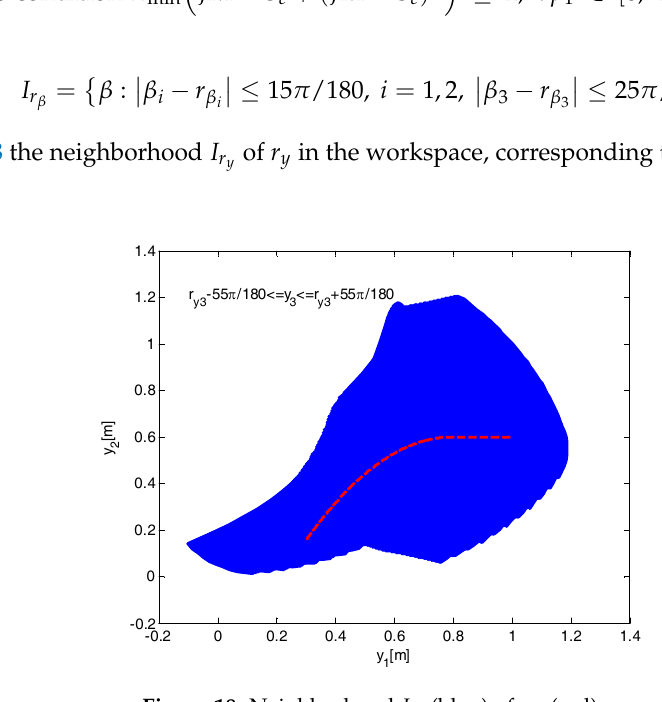
Neighborhood I r